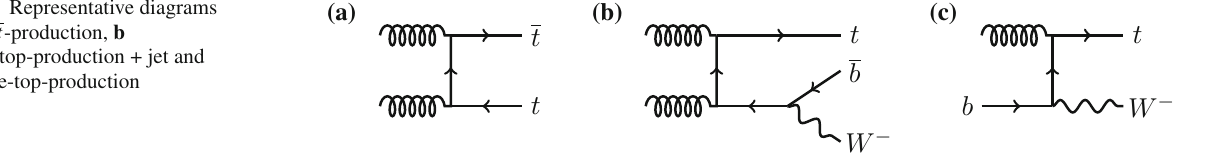
Fig. 1 Representative diagrams for a tt -production,